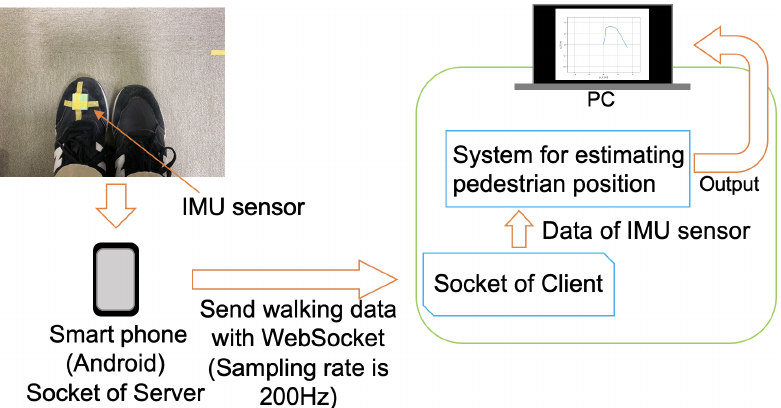
Figure 8. Implementation of the